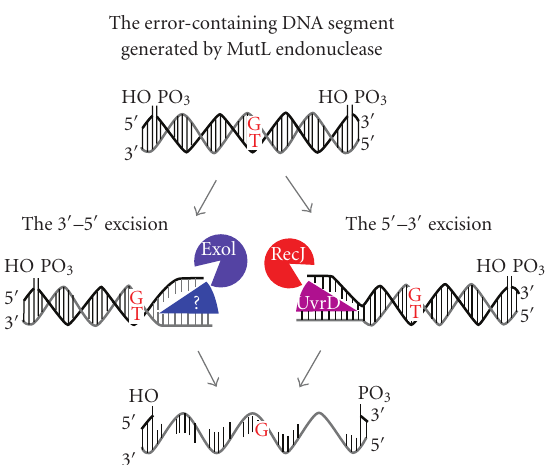
Figure 10: Two parallel pathways of excision reaction in T. thermophilus . RecJ (red) and ExoI (purple) are thought to be responsible for the 5 (cid:2) - and 3 (cid:2) -directed excision, respectively. UvrD helicase (magenta) functions in cooperation with RecJ. DNA helicase (blue) which translocates 5 (cid:2) to 3 (cid:2) direction has been unknown.